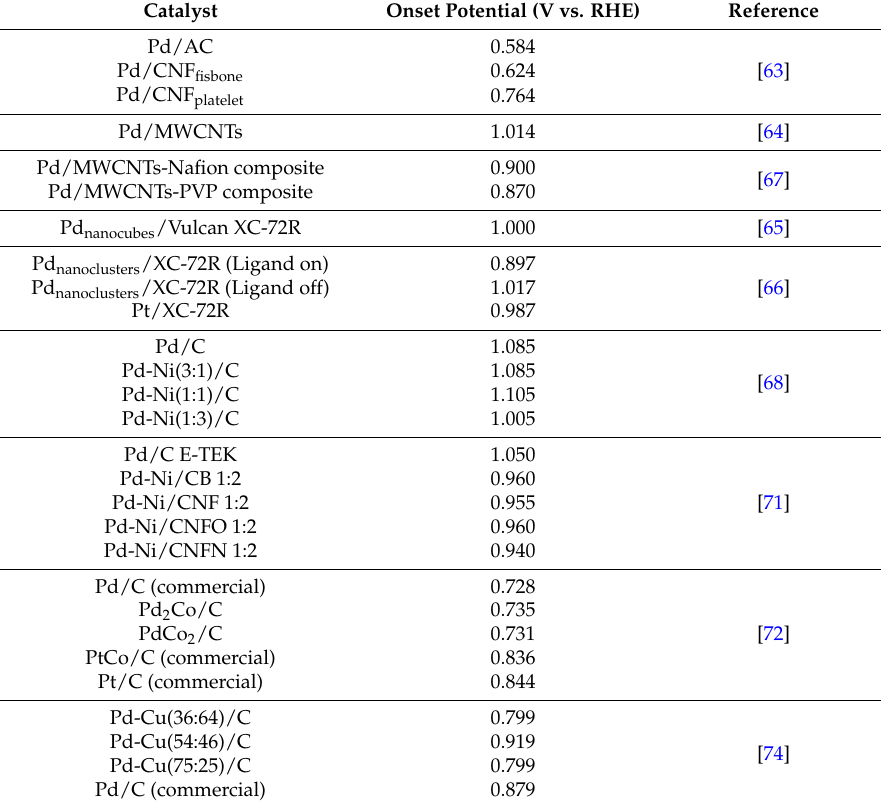
Table 6. Onset potential values for the ORR performed on carbon-supported Pd-based